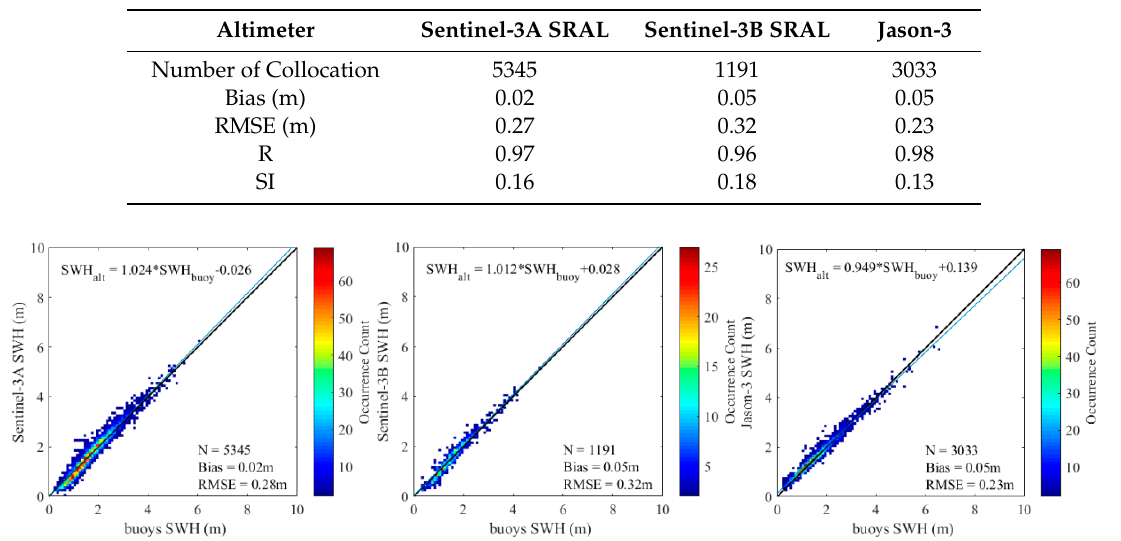
Figure 10. Comparisons of SWH between the Sentinel-3A, Sentinel-3B, and Jason-3 altimeters and the NDBC